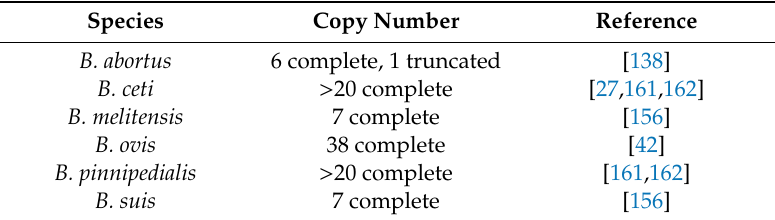
Table 1. IS711 number according to “classical Brucella ”